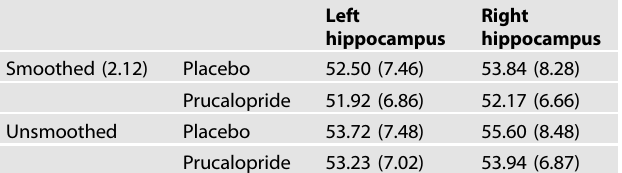
individually normalising for total brain volume (FSL FIRST vertex: p = 0.55 (right hippocampus), p = 0.07 (left hippocampus)). There was also no difference between groups in either global blood fl ow (Oxford_ASL: p = 0.73 (grey matter), p = 0.65 (white matter)) or regional blood fl ow (placebo > prucalopride, p = 0.70; prucalo- pride > placebo, p = 0.36). Whole-brain and hippocampal ROI results were similar with and without correction for cerebral perfusion and grey matter maps, and sex (see Supplementary Figure 1). Left and right hippocampal perfusion did not differ between groups: smoothed data p = 0.79 (left hippocampus), p = 0.47 (right hippocampus) (see Table 2). Native language and post- scan recall accuracy were not correlated using linear regression ( R 2 = 0.007).